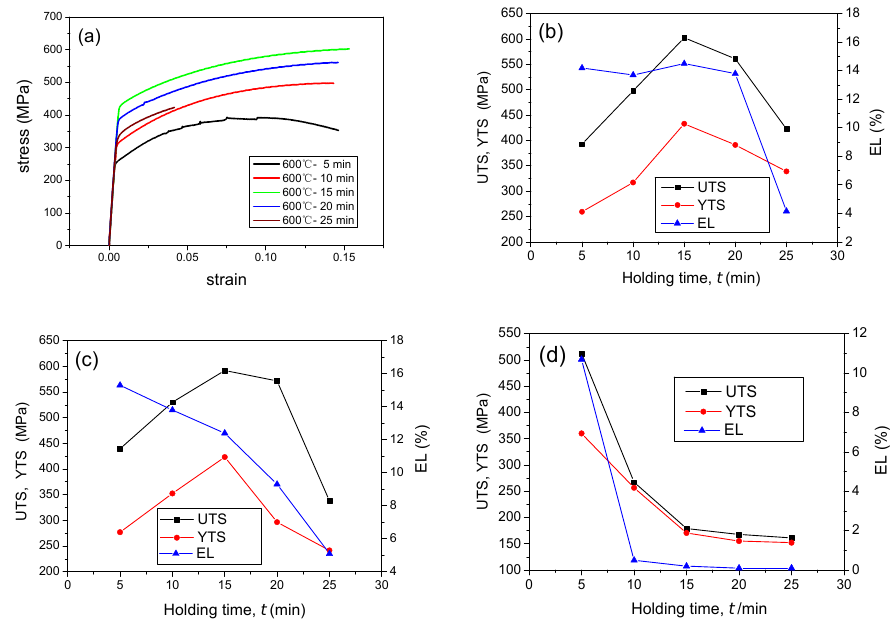
Figure 8. ( a ) The representative stress–strain curves of the RAP ‐ processed samples soaked at 600 °C for 5–25 min and the ultimate tensile strength, yield strength, and elongation versus temperatures and holding time of the RAP ‐ processed 7075 aluminum alloy, ( b ) 600 °C; ( c ) 610 °C; ( d ) 620 °C.